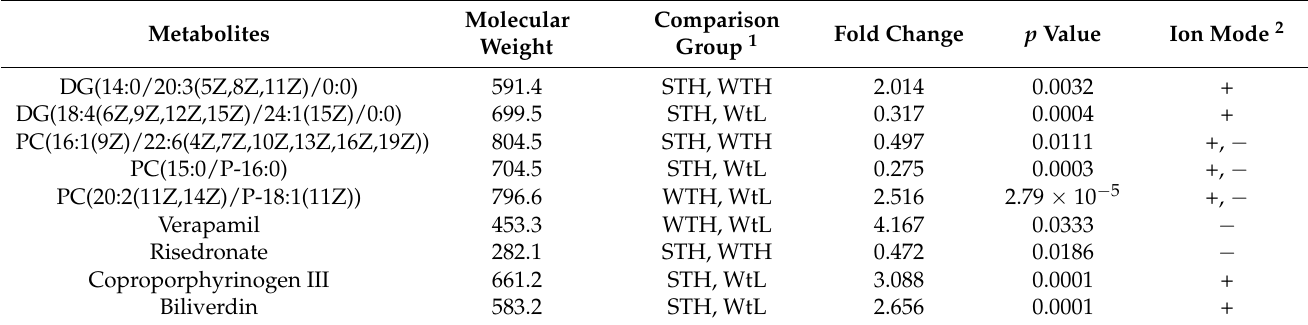
Table 3. Description of metabolite molecules potentially contributing to eggshell